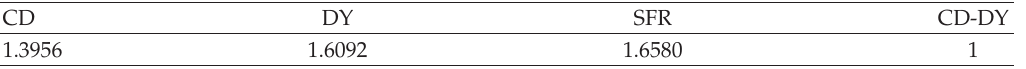
Table 2: Relative e ffi ciency of the CD, DY, SFR, and the mixed spectral CD-DY